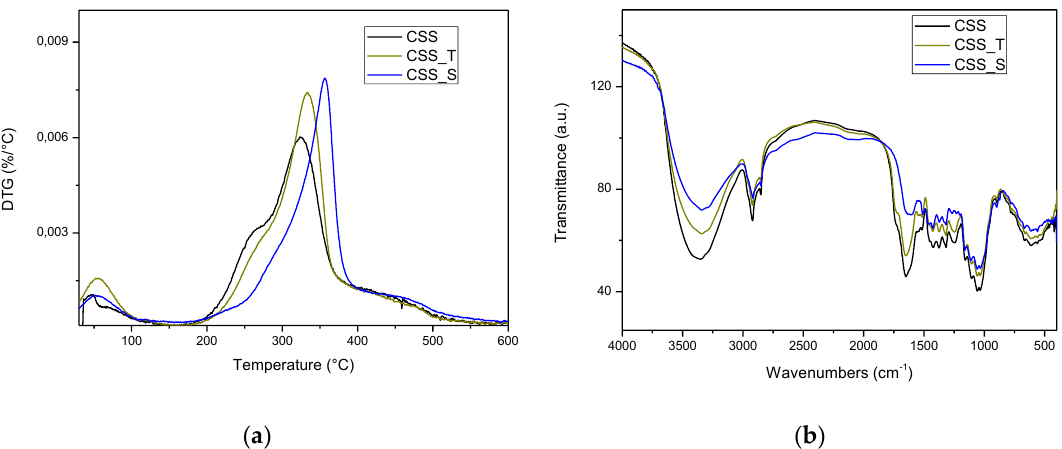
Figure 1. Derivative thermograms (DTG) curves ( a ) and Fourier Transform Infrared (FTIR) spectra ( b ) of as received, treated, and silane-treated coffee silverskin (CSS).